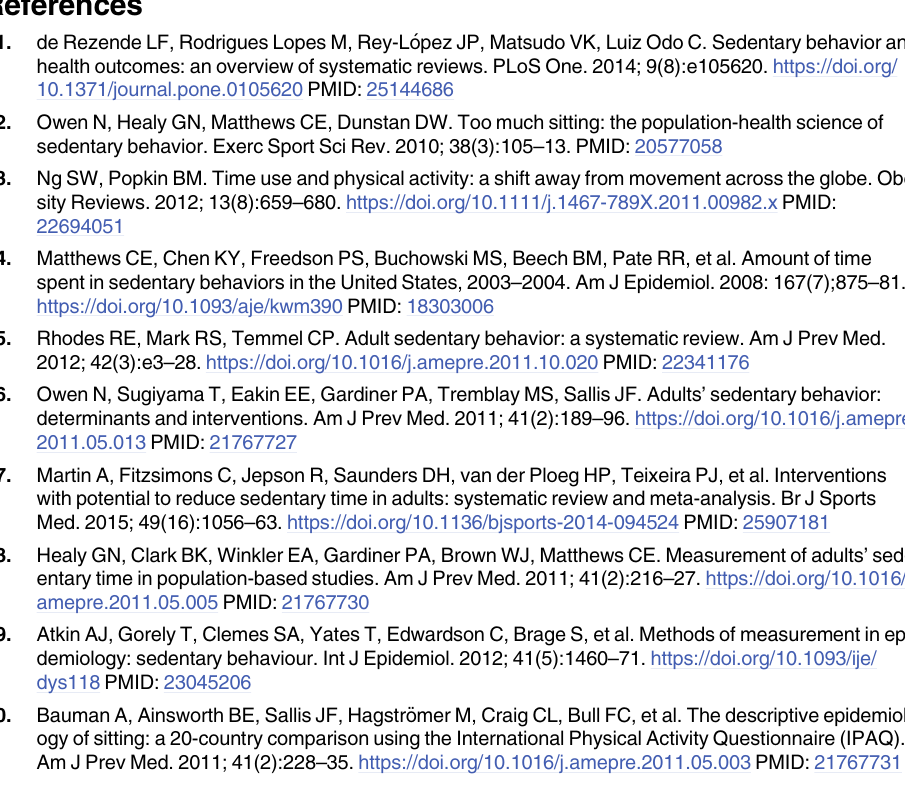
S2 Table. Mean differences in sedentary outputs between monitors. Values [monitors